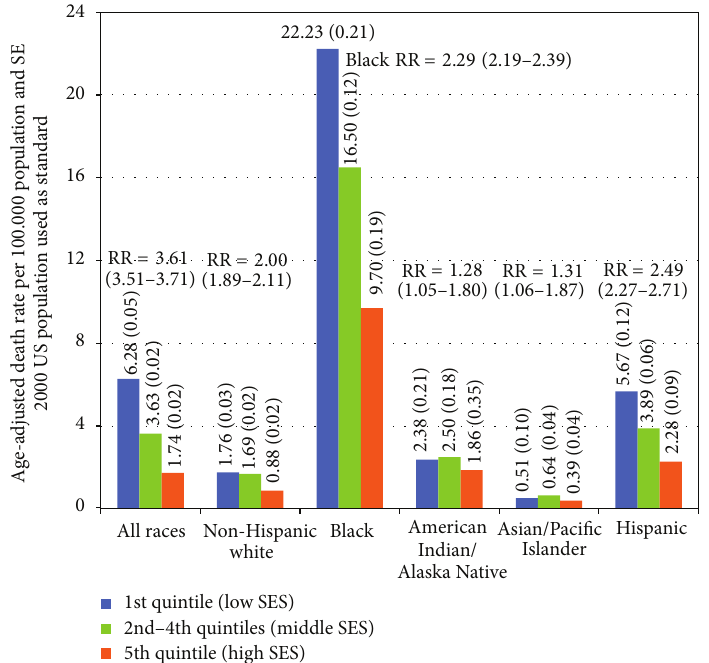
Figure 6: HIV/AIDS mortality by race/ethnicity and socioeconomic deprivation level, United States, 2005–2009. RR is ratio of mortality rate for the 1st quintile (low SES) to that for the 5th quintile (high SES). The standard normal 𝑍 test can be used to evaluate the statistical significance of the difference in mortality rates between any two groups at one point in time or to test for change in mortality rates between two time points for a specific group. If the absolute value of the 𝑍 -statistic = ( R 1 − R 2)/ SQRT [( SE ( R 1)) 2 + ( SE ( R 2)) 2 ] ≥ 1.96 , then the difference is statistically significant at the 0.05 level. If the test statistic ≥ 2.58, then the difference in the rates is significant at the 0.01 level, where R1 is mortality rate for the first demographic group, R2 is mortality rate for the second demographic group, and SE (R1) and SE (R2) are the standard errors associated with R1 and R2, respectively. For example, during 2005–2009, the HIV/AIDS mortality rate for Hispanics in the most-deprived socioeconomic group (5.67) was 3.2 times higher than the corresponding rate for non-Hispanic whites (1.76), and this difference was statistically significant at the 0.01 level (computed 𝑍 -value = 31.61). The 95% confidence interval for a specific mortality rate can be constructed by using the formula = rate ± 1.96 ∗ standard error.